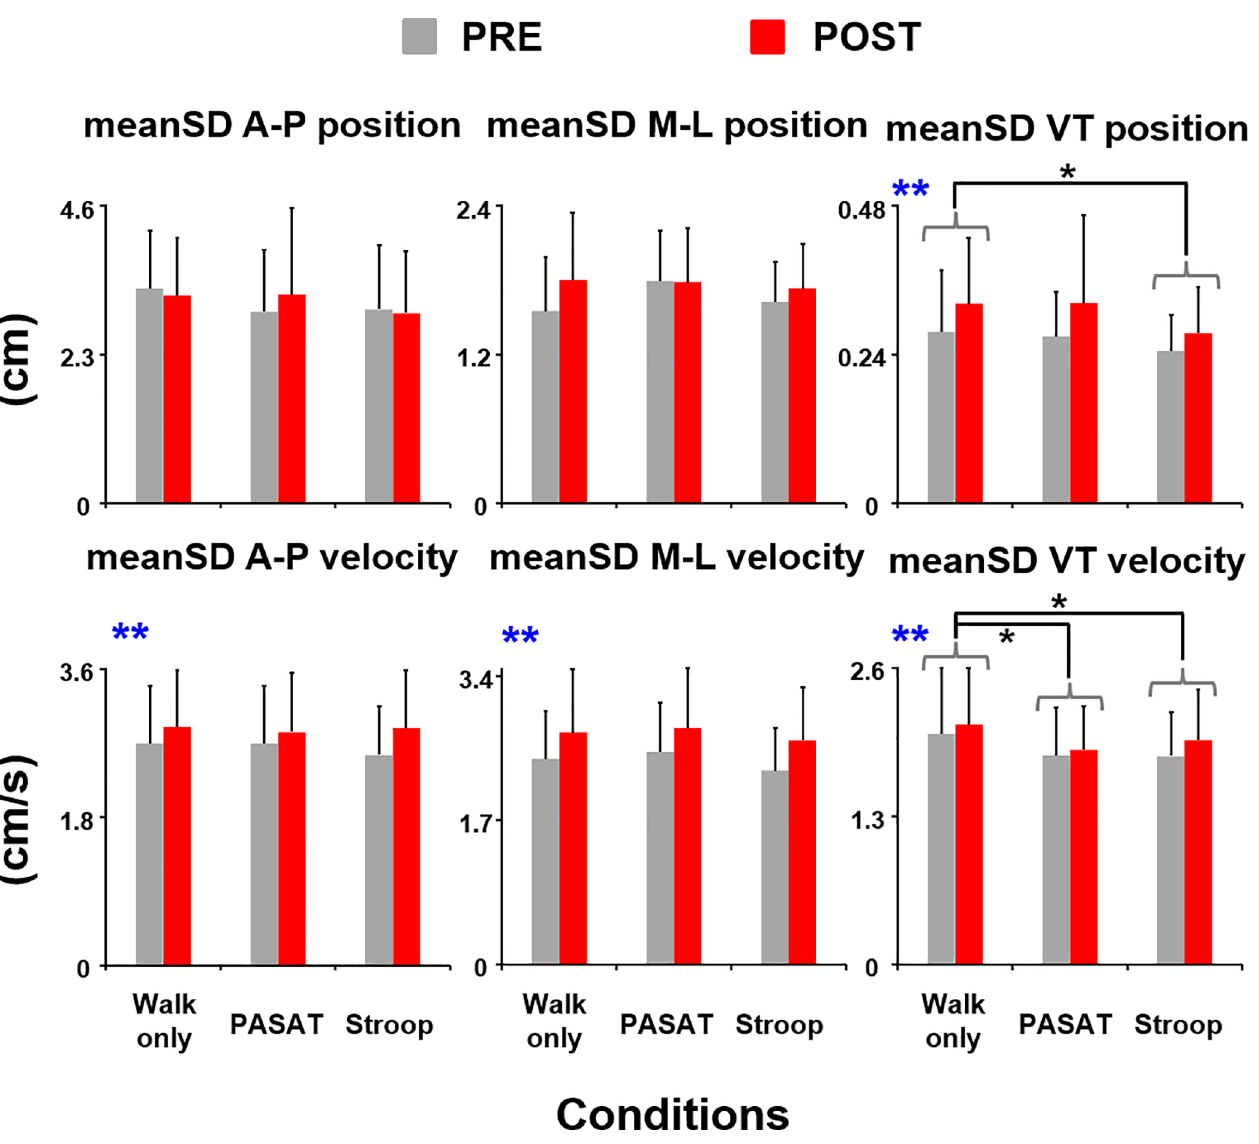
Fig 5. Mean standard deviation (meanSD) of C7 marker positions and velocities. meanSD of C7 marker positions (top panel) and meanSD of C7 marker velocities (bottom panel) in the A-P, M-L, and VT directions before (PRE, grey bars) and after (POST, red bars) the exercise session. Error bars represent 1 STD. (cid:3)(cid:3) indicates significant difference between the PRE and POST. (cid:3) indicates significant difference from the walking only condition (THSD, p < 0.05).